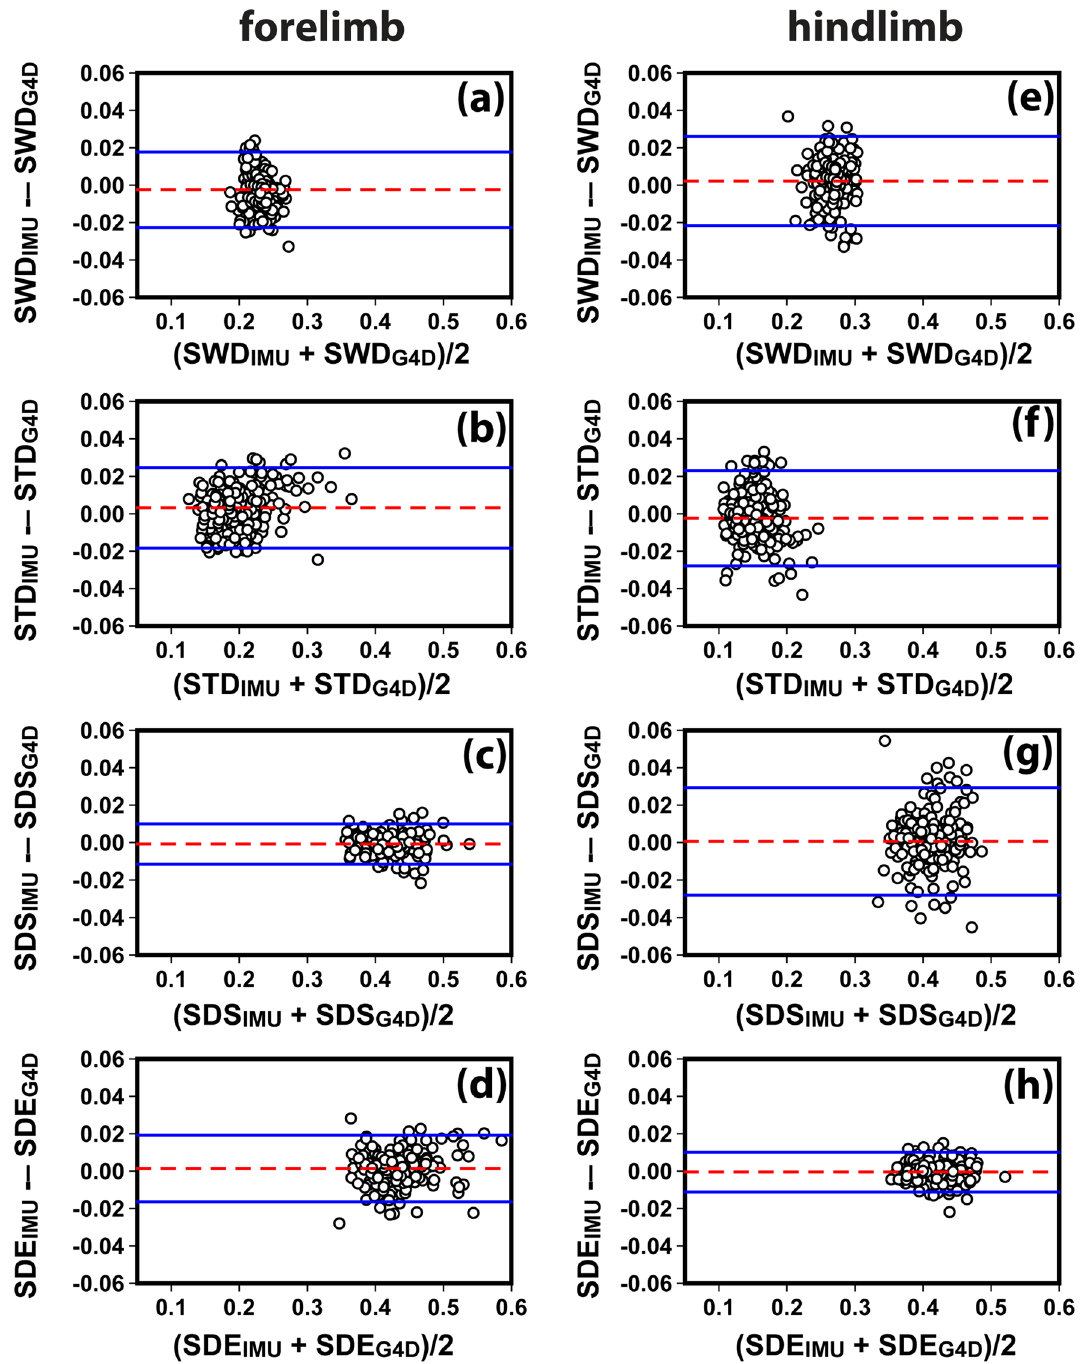
Figure 5. Bland and Altman plots of the four gait parameters (SWD, STD, SDS, SDE) to study the agreement between IMU (with subscript IMU) and GAIT4Dog (with subscript G4D) measurements in the synchronized validation study. The horizontal axes are the arithmetic mean of IMU and G4D readings, and the vertical axes are their difference. The measurement unit is second in all axes. The dashed lines are the mean bias between the two systems. The solid lines indicate the 95% confidence interval of the agreement. SWD, swing duration; STD, stance duration; SDS, stride duration based on swing start; SDE, stride duration based on swing